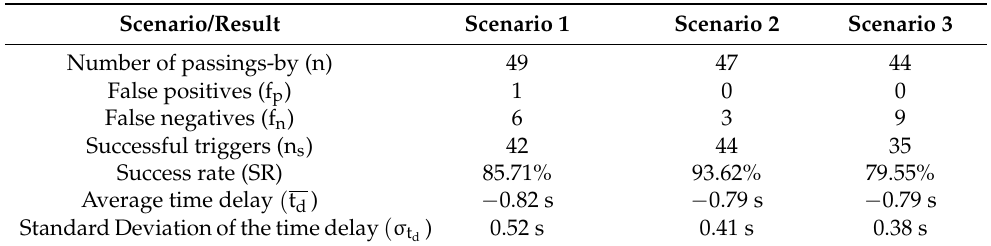
Table 11. Results of real-time localization for the Trust Manga Bluetooth 4.0 USB adapter, using the calibration values from the LM Technologies LM1010 adapter. Calibration values are shown in Table